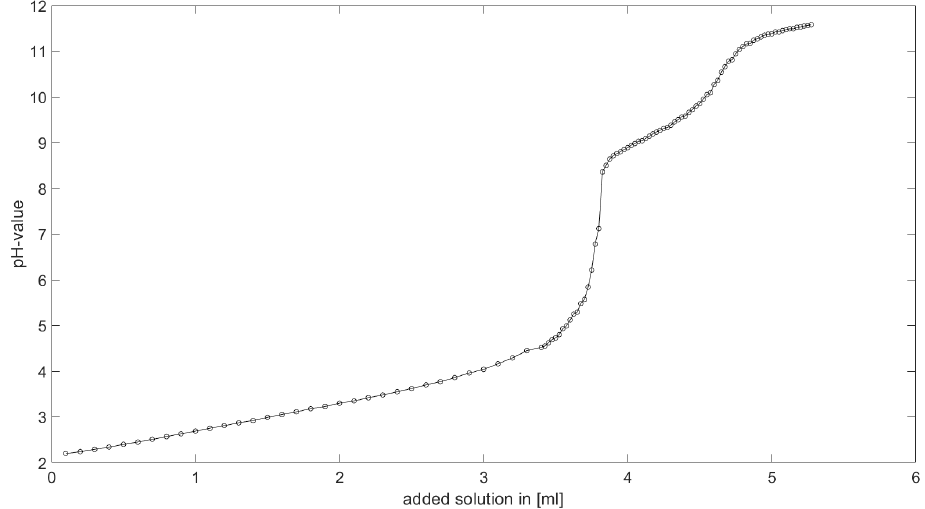
Figure 10. Experimentally determined titration curve for the Cit-Ni